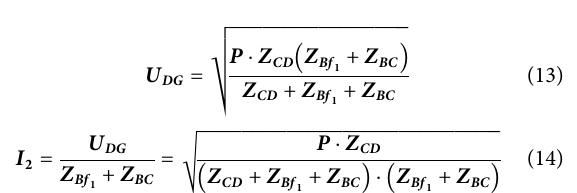
FIGURE 14 Equivalent circuit diagram of a fault at the end of line AB.